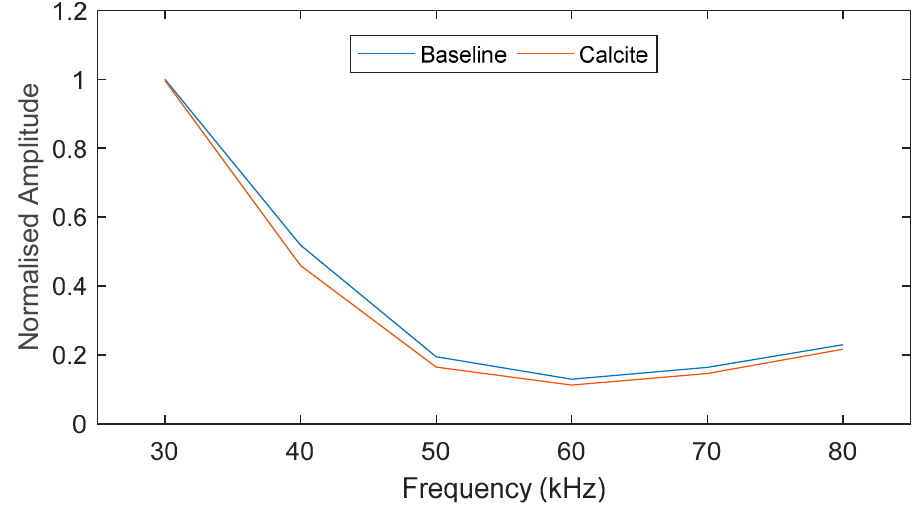
Figure 5. Comparison of maximum receiving amplitude at different input frequencies.